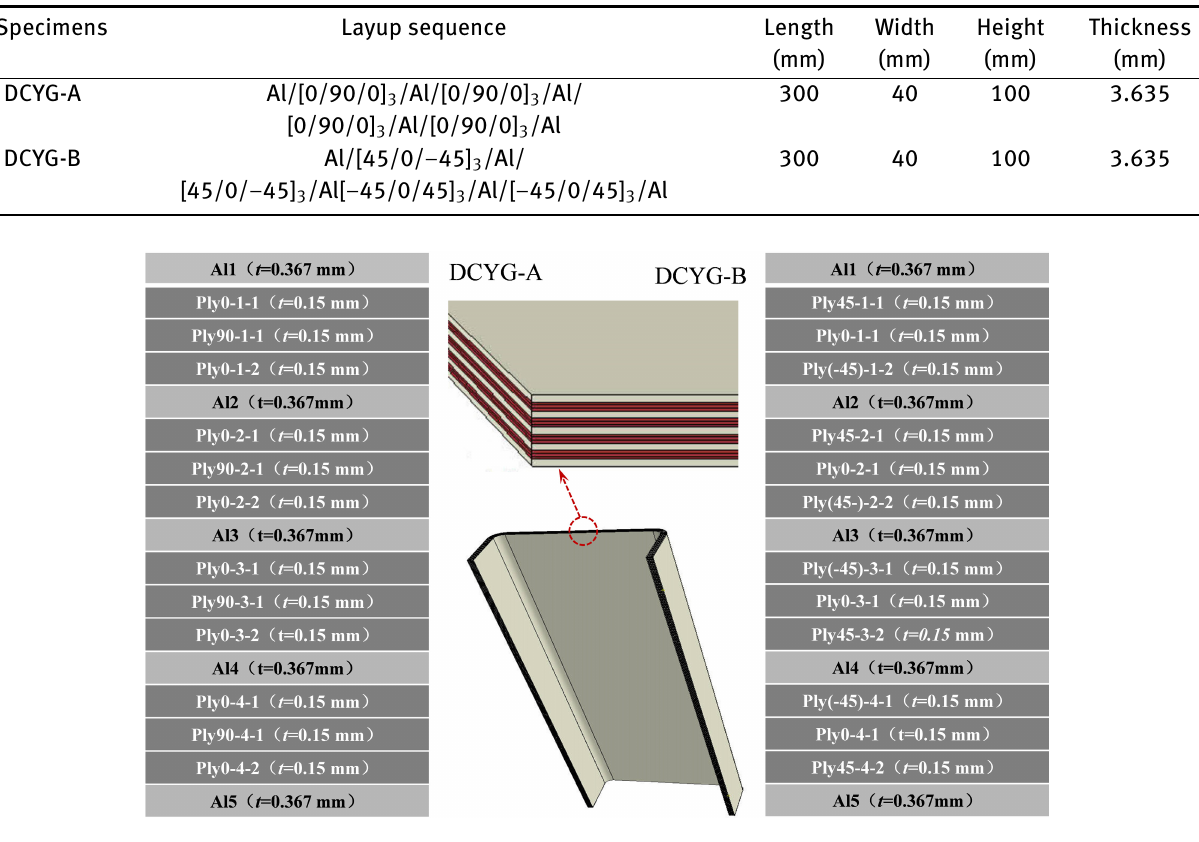
Figure 2: Schematic of the geometry and laminate configurations of CARALL specimens.